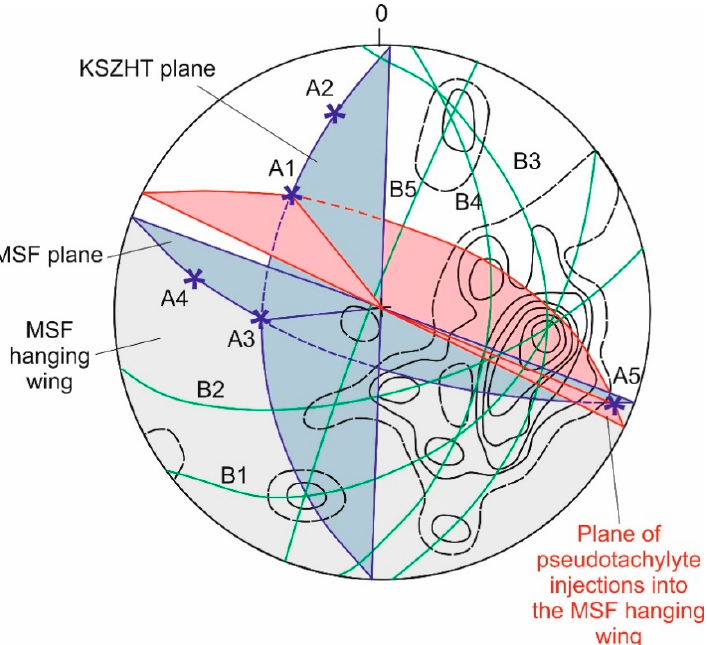
Figure 3. Outputs of axes of tectonic fractures in the MSF mylonites with reconstructed dips of the MSF and KSZHT planes in the lower hemisphere. Fracture belts B1, B2, B3, B4, and B5 correspond to the outlets of axes A1, A2, A3, A4, and A5, respectively. Orientations of 100 crack poles are plotted with a density of 13%, 11% . . . 3%, and 1%. Injected bands extend along the MSF plane. Injected bands, extended along the MSF plane, correspond to the antithetical fissures of its south-southwestern hanging wing.